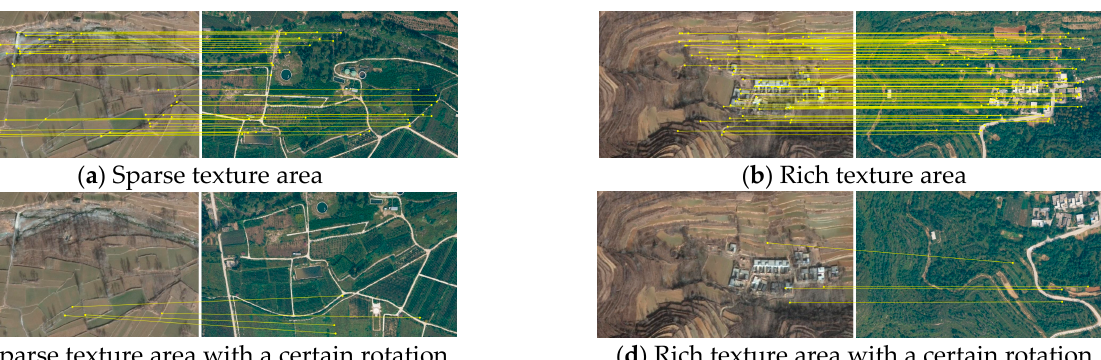
Figure 11. Partial matching results of RIFT + NNDR + FSC on the test dataset.